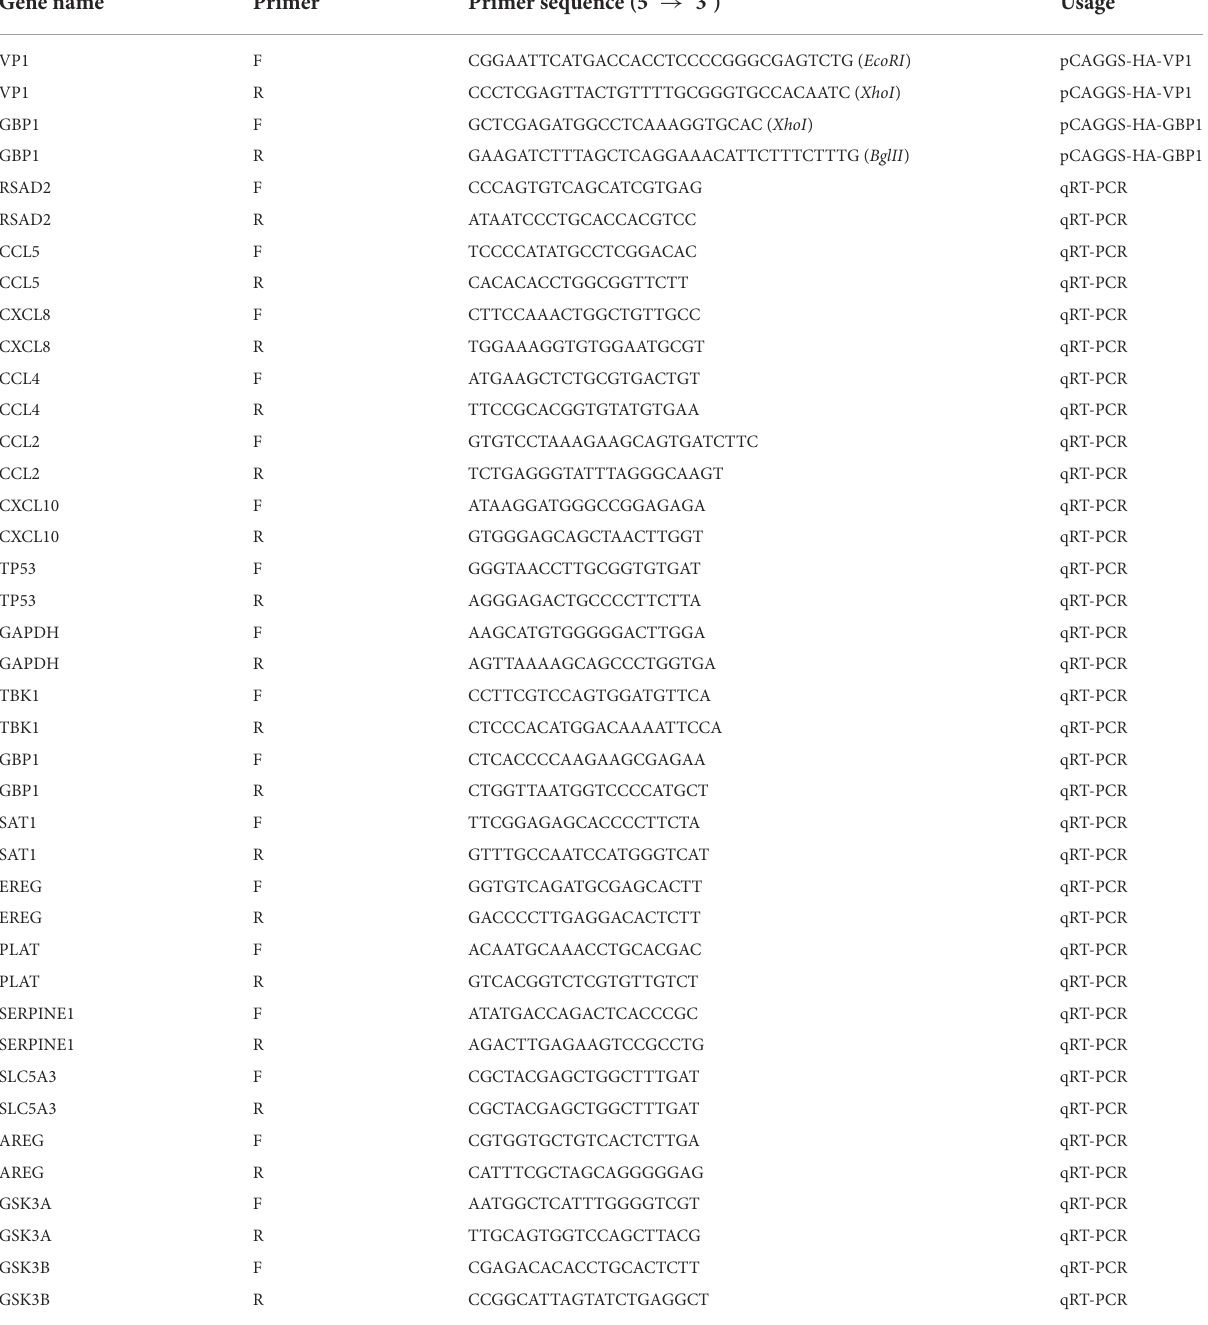
TABLE 1 Primers for plasmid construction and real-time